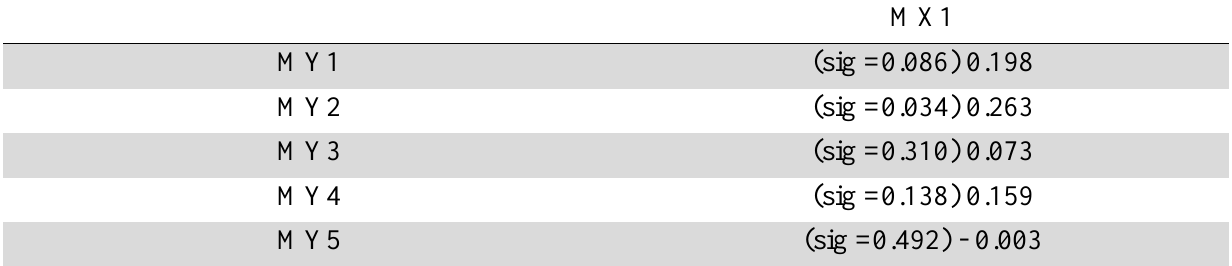
Correlation coefficients between reward power (MX1) and the conflict management styles (MY1 through